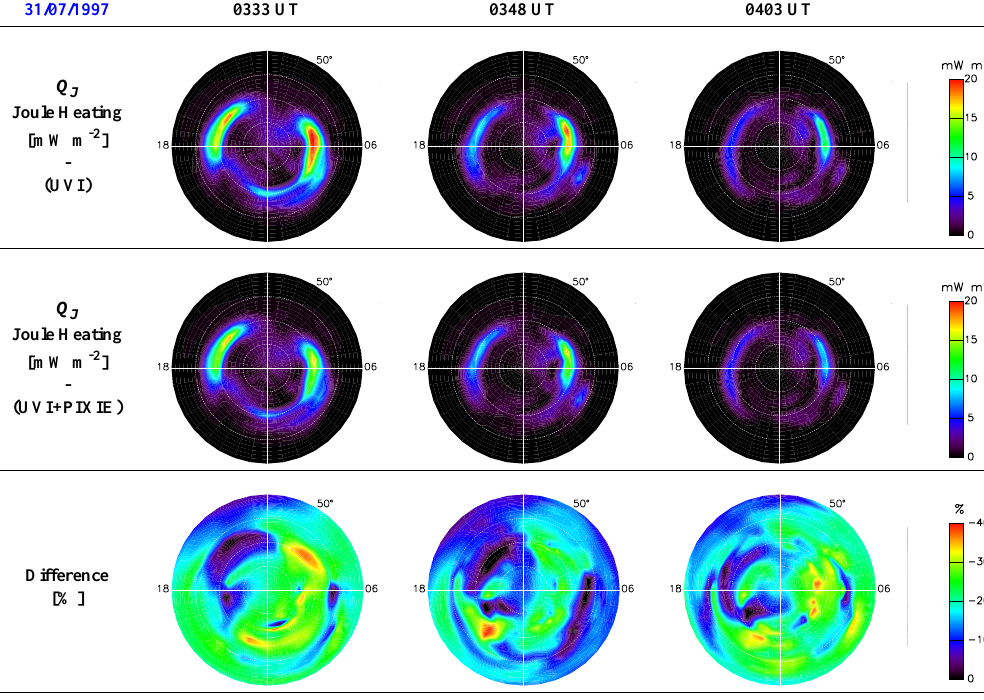
Fig. 10. Polar plots of Joule heating derived without (upper row) and with (middle row) PIXIE data between 03:30 and 04:05 UT on 31 July 1997. The differences in percent when including the PIXIE data are presented in the bottom